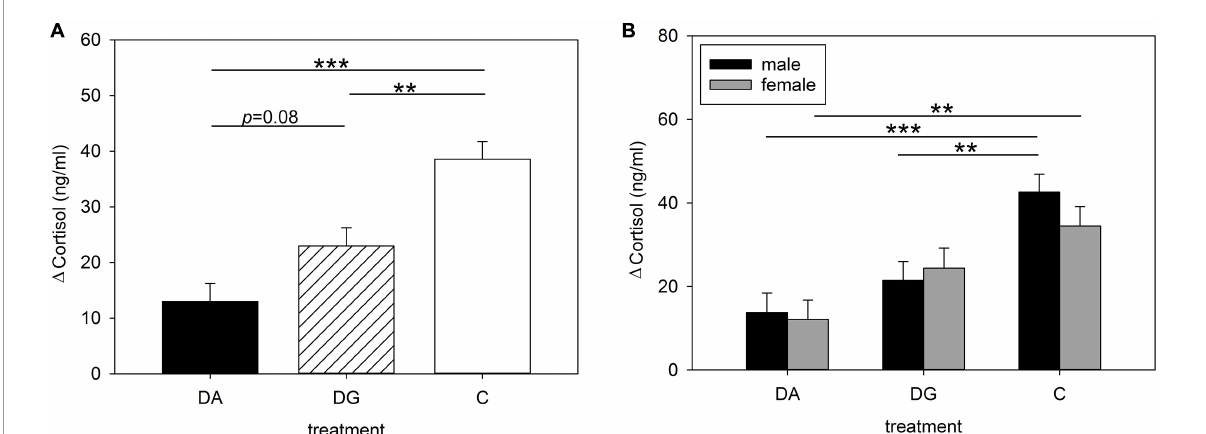
FIGURE2 Increases in plasma cortisol concentrations of (A) all; (B) male and female piglets of the three treatment groups DA (deprivation alone), DG (deprivation in a group with littermates) and C (control, no deprivation) during the open-field/novel-object test. Results are presented as LSM ± SE. Significant differences are marked with asterisks (** p < 0.01; *** p < 0.001; Tukey-Kramer test; n = 25–30 per treatment group and sex).